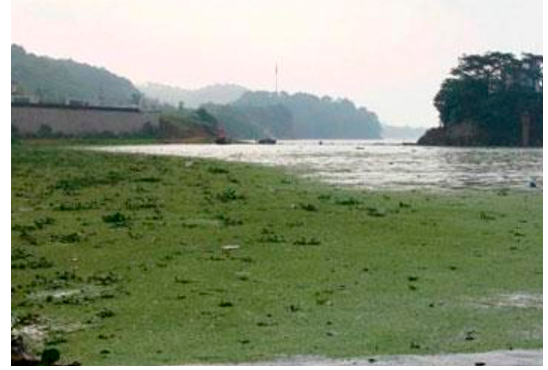
Figure 6. Bloom of blue ‐ green algae in Poyang Lake (This photo was taken on 12 June 2015).